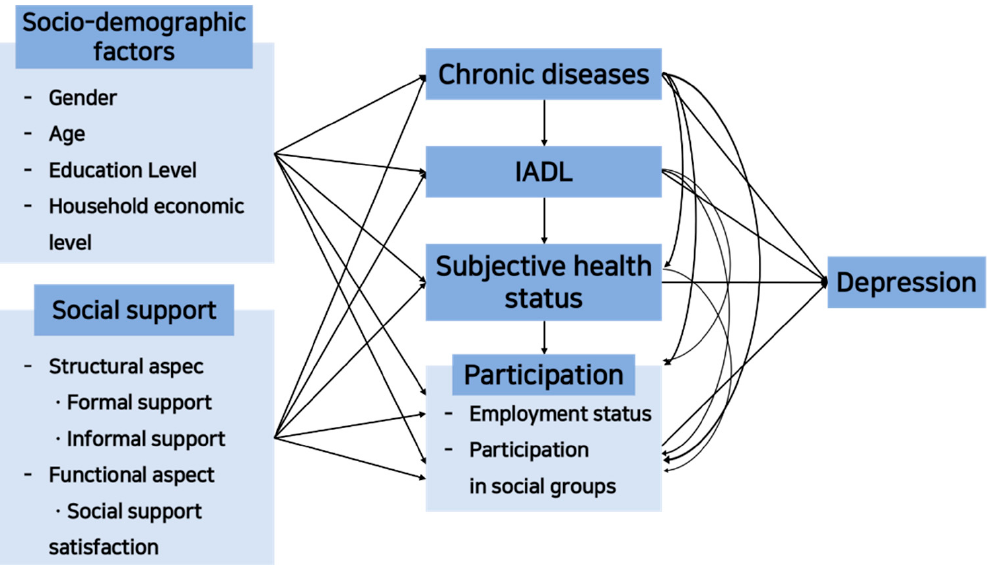
Figure 2. Model framework.